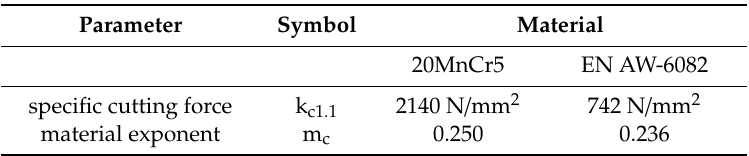
Table 2. Summary of Kienzle